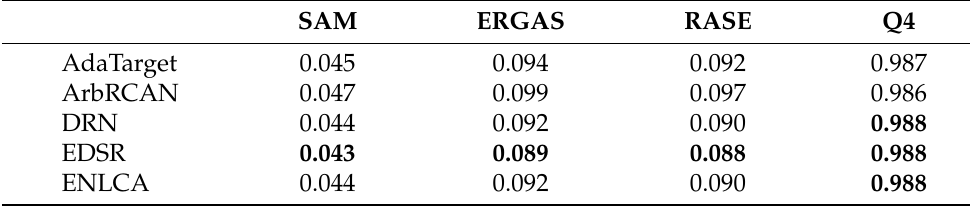
Table 6. Spectral evaluation on FY4ASRcolor with re-trained